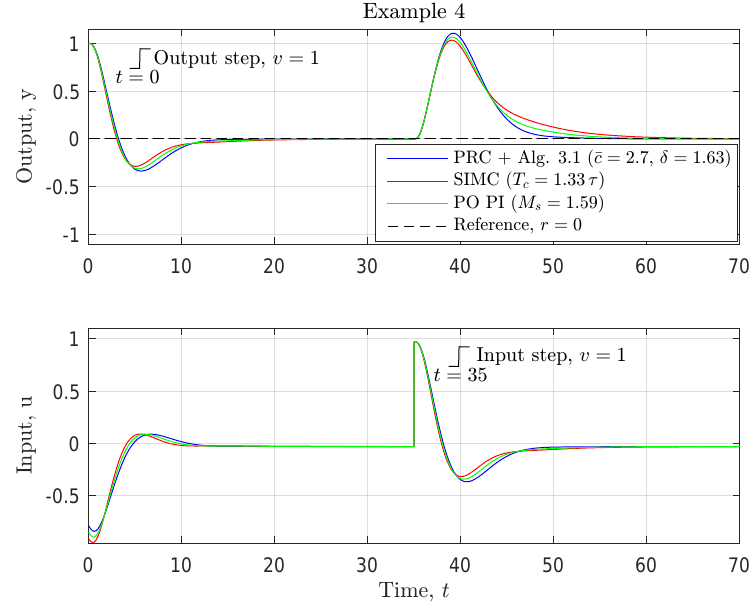
Figure 9. Example 4. Consider PI control of the higher order process model (Equation (47)). The figure illustrates the time-domain responses, given a prescribed robustness M s = 1.59, of the following methods: the PO PI controller vs. SIMC with closed loop time constant T c = 1.33 τ , and PRC + Algorithm 1 where the MP parameter setting ¯ c = 2.7 (proposed in Section 4) and RTDE δ = 1.63. An output disturbance unit step is presented at time t = 0 and an input disturbance unit step at time t =